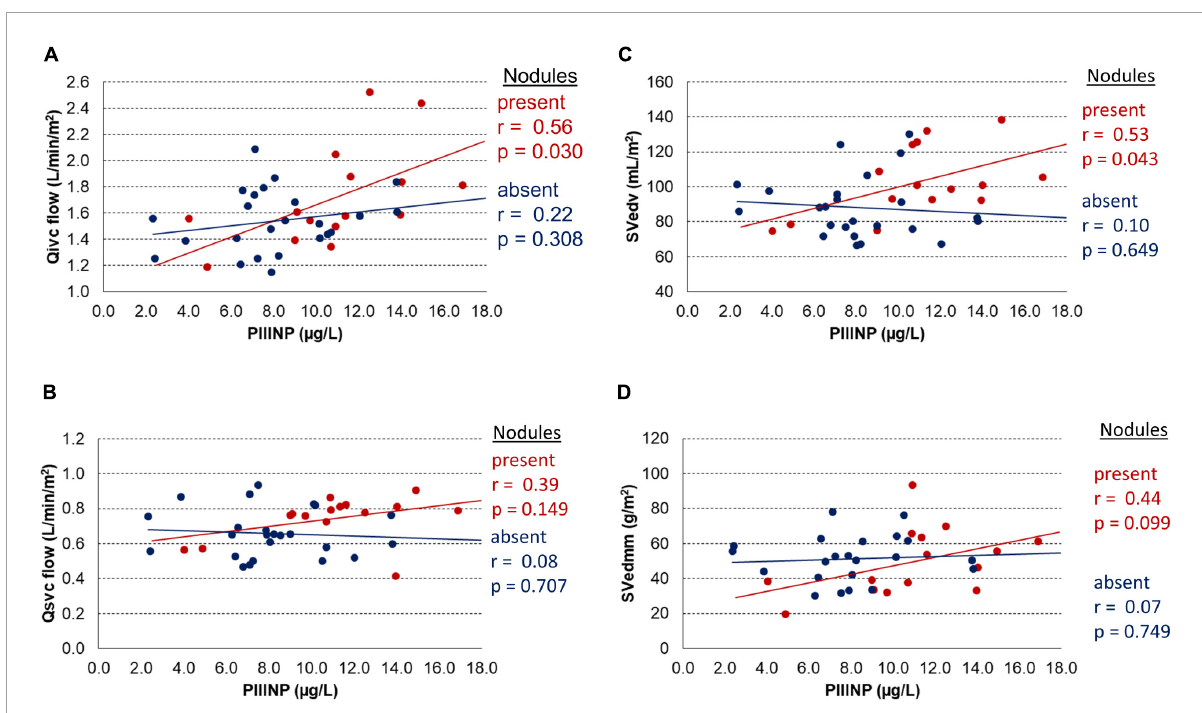
FIGURE2 Effects of procollagen III N-terminal peptide (PIIINP) stratified by the presence of liver nodules on: (A) inferior vena cava flow (Qivc), (B) superior vena cava flow (Qsvc), (C) end-diastolic volume (SVedv), (D) end-diastolic myocardial mass (SVedmm).